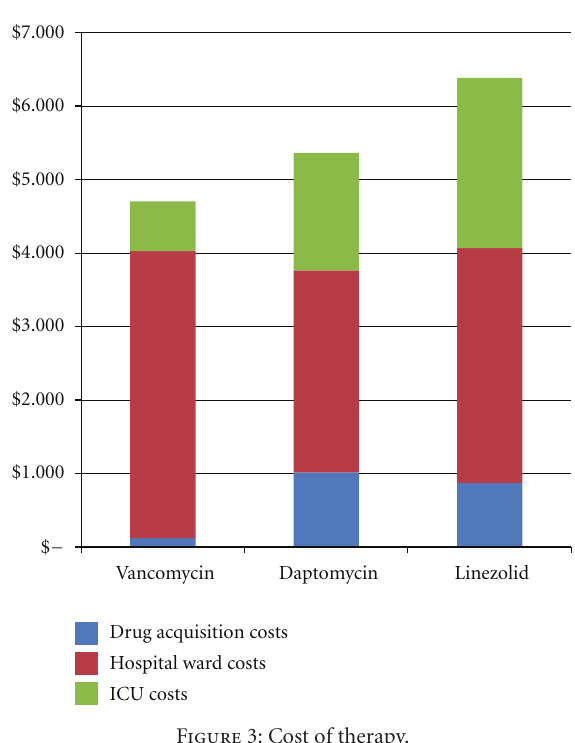
Figure 3: Cost of